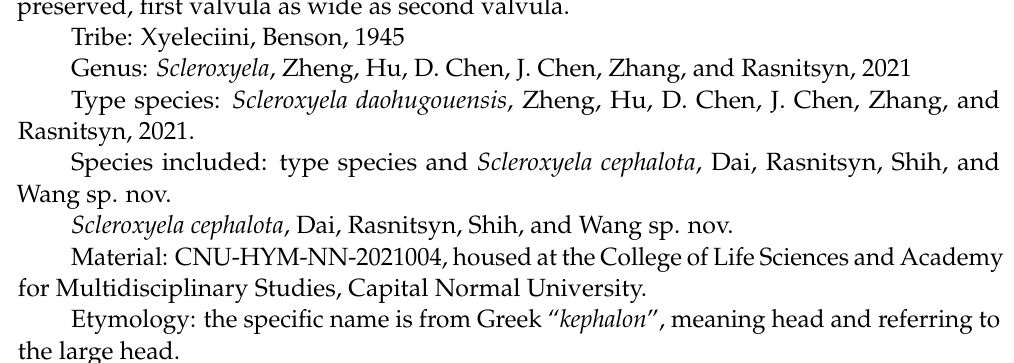
Figure 4. Different types of antennae in the subfamily Macroxyelinae. ( A ), Isoxyela rudis Zhang and Zhang, 2000. ( B ), Gigantoxyela quadrifurcata Rasnitsyn, 1966. ( C ), Scleroxyela daohugouensis Zheng et al., 2021. ( D ), Leptoxyela eximia gen. et sp. nov. ( E ), Ceratoxyela decorosa Zhang and Zhang, 2000. Leptoxyela eximia Dai, Rasnitsyn, and Wang gen. et sp. nov. Material: CNU-HYM-LB-2021002, housed at the College of Life Sciences and Acad- emy for Multidisciplinary Studies, Capital Normal University. Etymology: the specific name is from Latin “ eximius ”, meaning exceptional and re- ferring to the well-preserved fossil specimen.